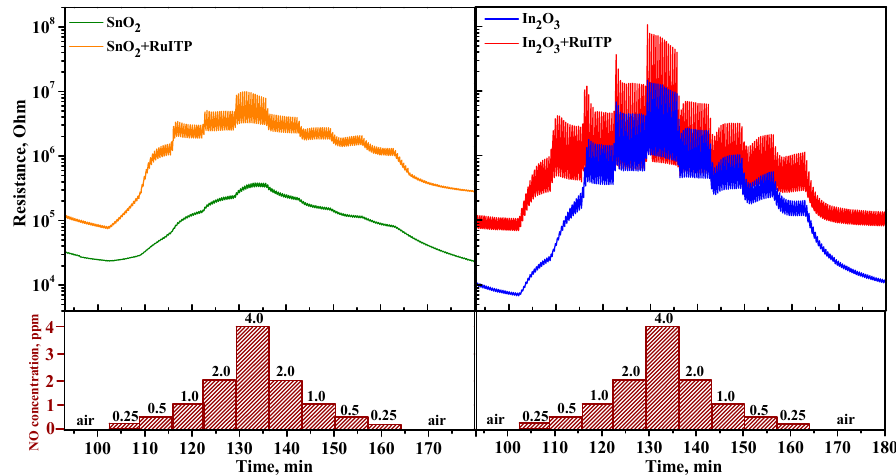
Figure 9. Room-temperature electrical resistance of the nanocrystalline SnO 2 and In 2 O 3 and hybrid samples under periodic illumination during stepwise change of the NO concentration.